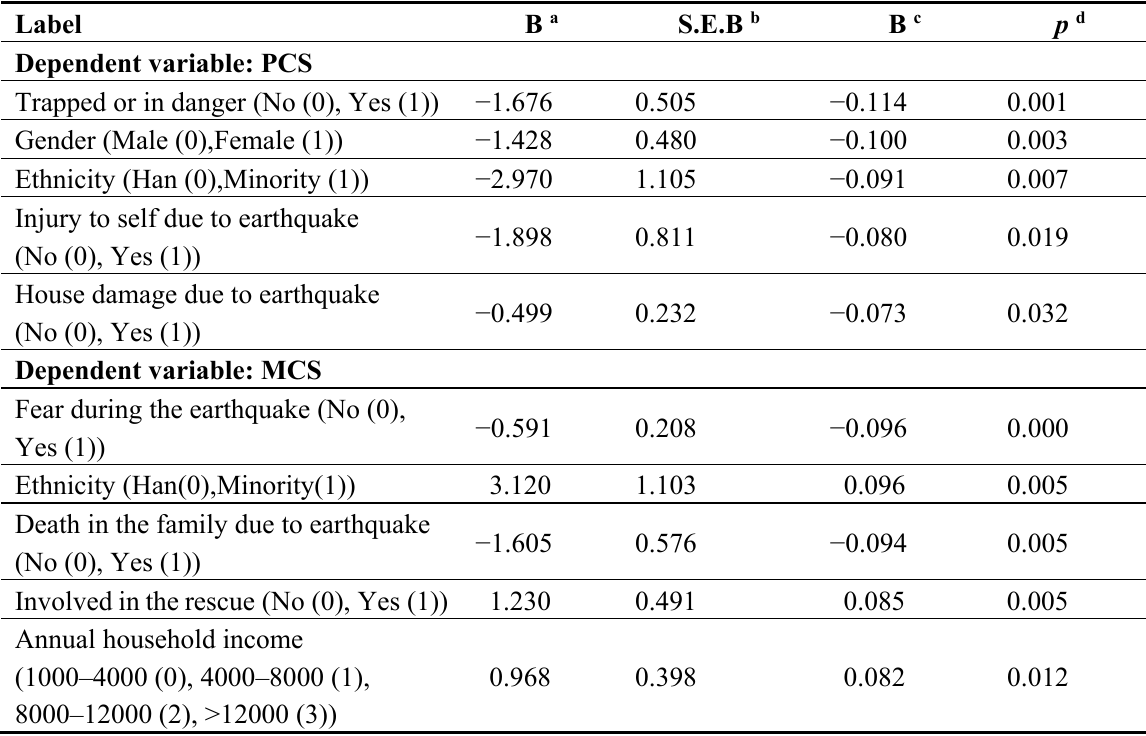
Table 2. Multiple stepwise regression analysis of factors independently associated with PCS and